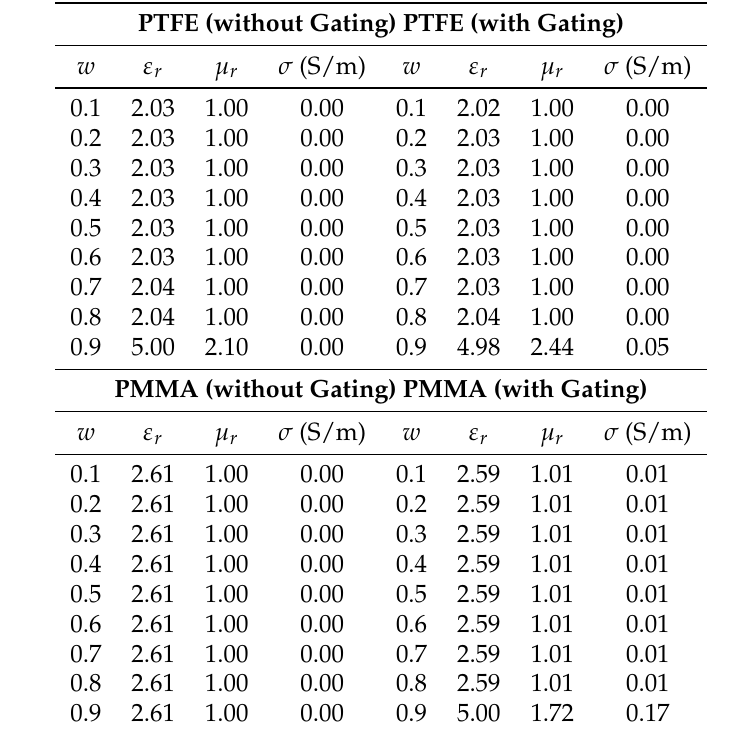
Table 3. Extracted parameters of the samples using the multi-frequency reconstruction with the measurements performed at distance r = 48 cm, using different weights w in